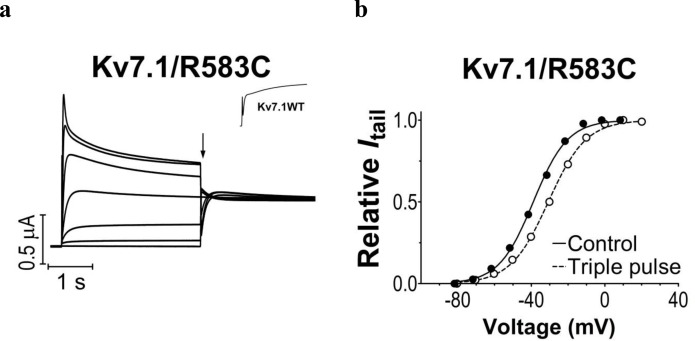
KV7.1/R583C mutant expressed in Xenopus oocytes.(a) The KV7.1/R583C mutant generates currents that inactivate at positive voltages. The holding voltage is –80 mV, and test voltages range between –80 and +40 mV for 3 s in 20 mV increments. The tail voltage is –20 mV. Tail currents are measured at the arrow. Inset: representative current trace at +40 mV for wild-type KV7.1. (b) Representative example of G(V) curves generated using the protocol in panel a (filled circles) or a triple pulse protocol (open circles) with a brief hyperpolarizing pulse (–140 mV for 20 ms) between the test pulse and the tail pulse to release a fraction of channels from inactivation. The triple pulse protocol generates a G(V) that is shifted ~9 mV towards positive voltages (V50 = ~ –39 mV for the regular protocol and –30 mV for the triple pulse protocol), which matches the G(V) of the wild-type KV7.1 fairly well (V50 = –29.4 mV).